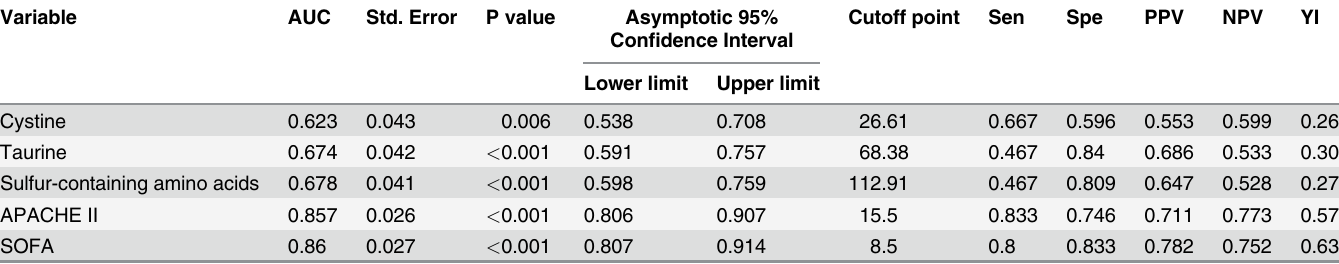
Table 3. Areas under the ROC curves as the outcome prediction values of sulfur-containing amino acids.